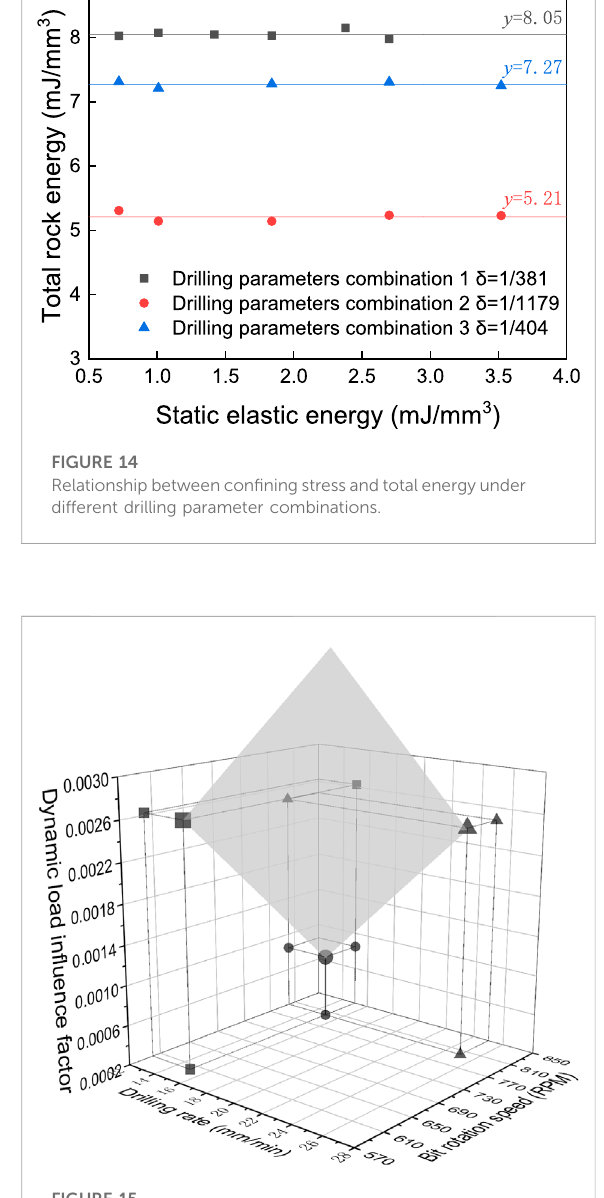
FIGURE 15 Relationship between dynamic load in fl uence factors and drilling rate and bit rotation